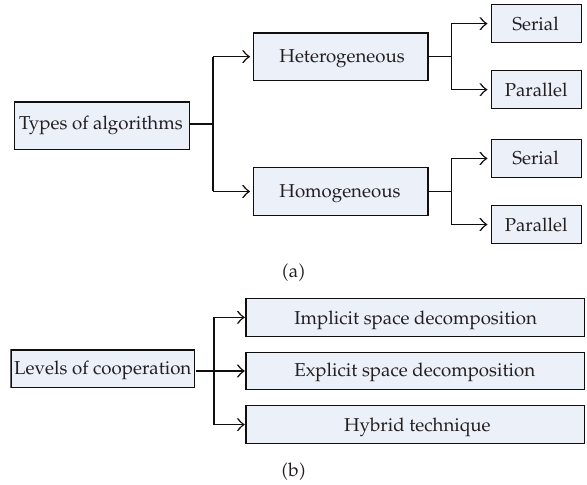
Figure 3: Taxonomy of the Cooperative Search Algorithms. (cid:2) a (cid:3) Taxonomy based on the types of used algorithms; (cid:2) b (cid:3) Taxonomy based on the level of space